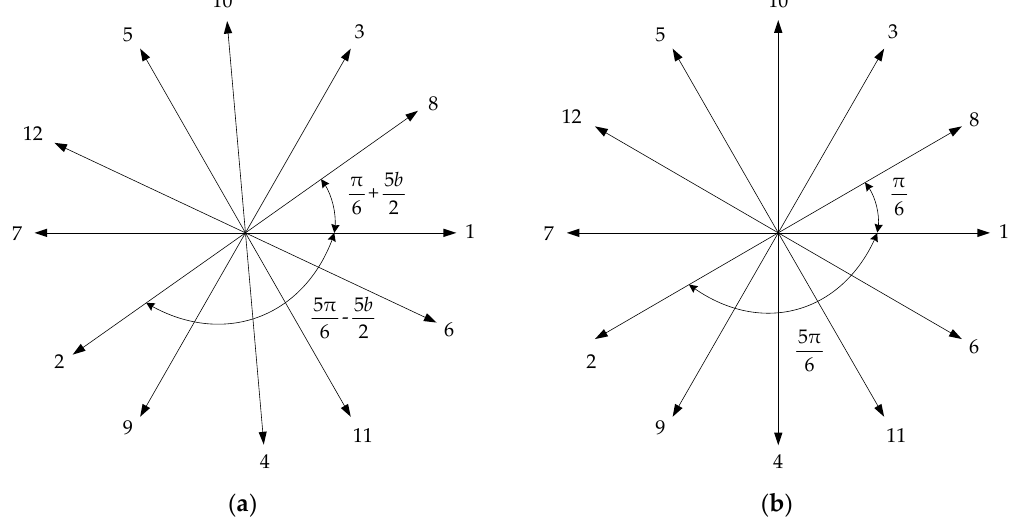
Figure 2. The star graphs of the fundamental electromotive force: ( a ) DRPMSM; ( b ) the traditional PMSM without small teeth.